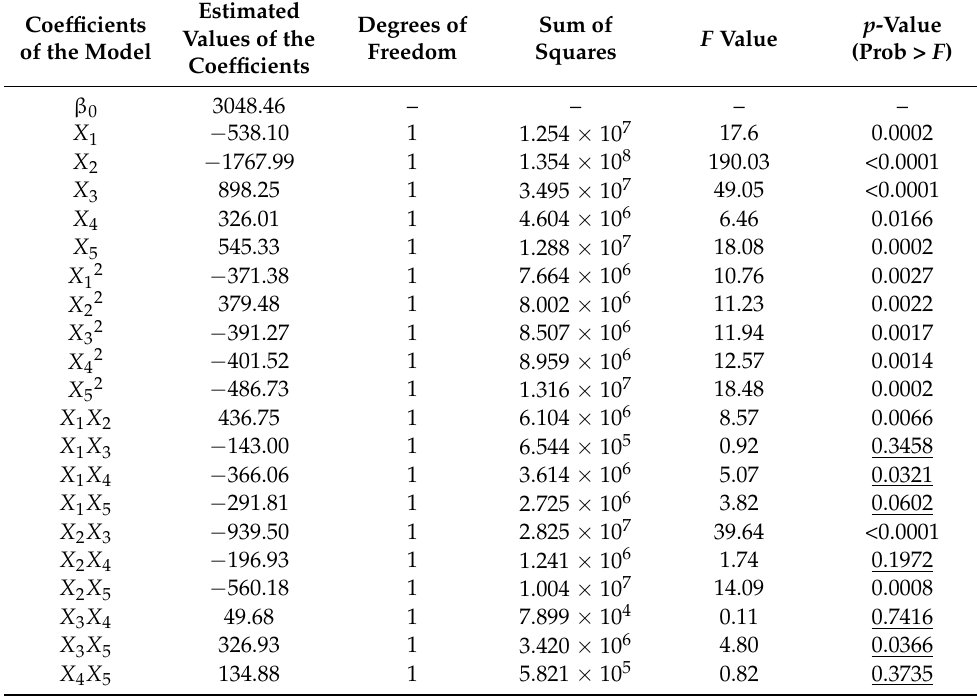
Table 5. Variance analysis result for the quadratic regression